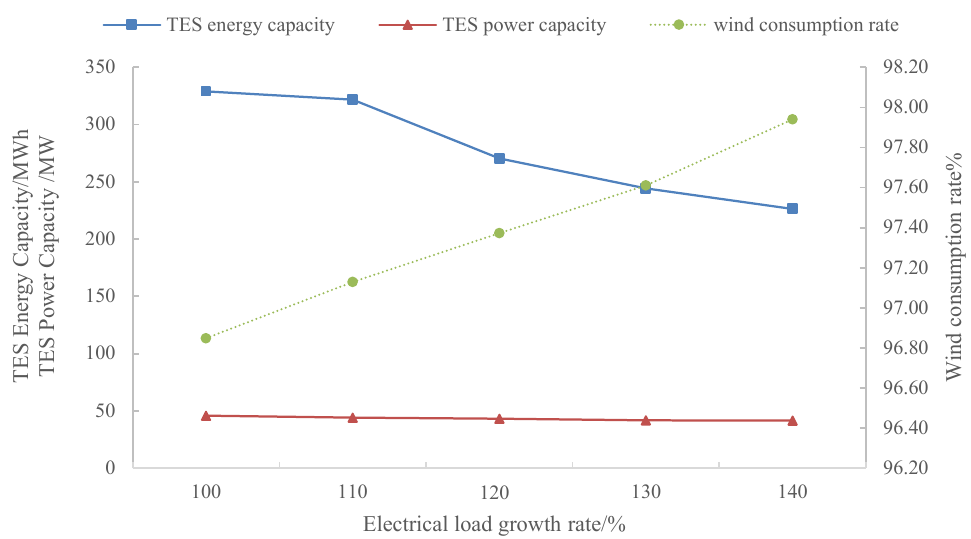
Figure 12. The impact of increased electrical load on TES configuration and wind power